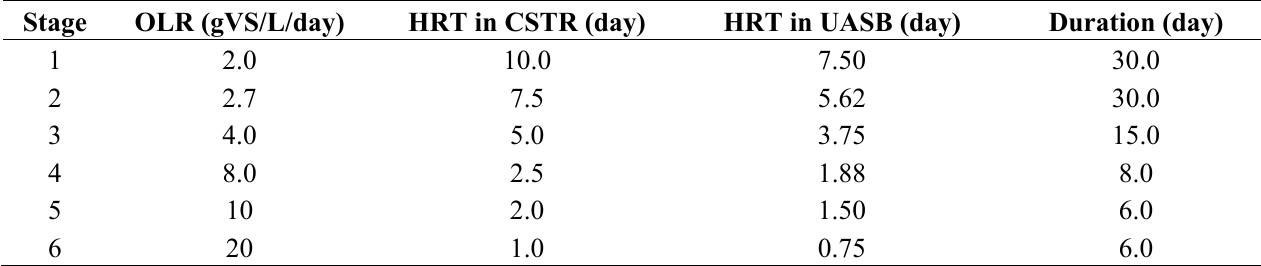
Table 1. The process conditions including the OLR and their respective HRT, flow rate and duration in each stage of the experimental